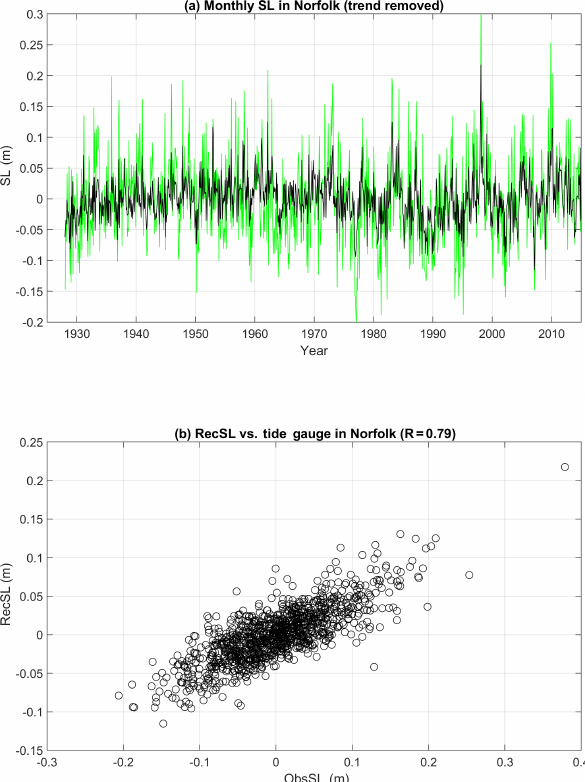
Figure 3. (a) Global mean sea level (black line) and regional mean sea level over the area shown in Fig. 2 (green line). (b) Difference between the monthly regional and global mean sea levels (green line). Heavy red and blue lines represent low-pass-filtered records obtained from the sum of EMD modes with timescales longer than ∼ 5 and ∼ 10 years, respectively.